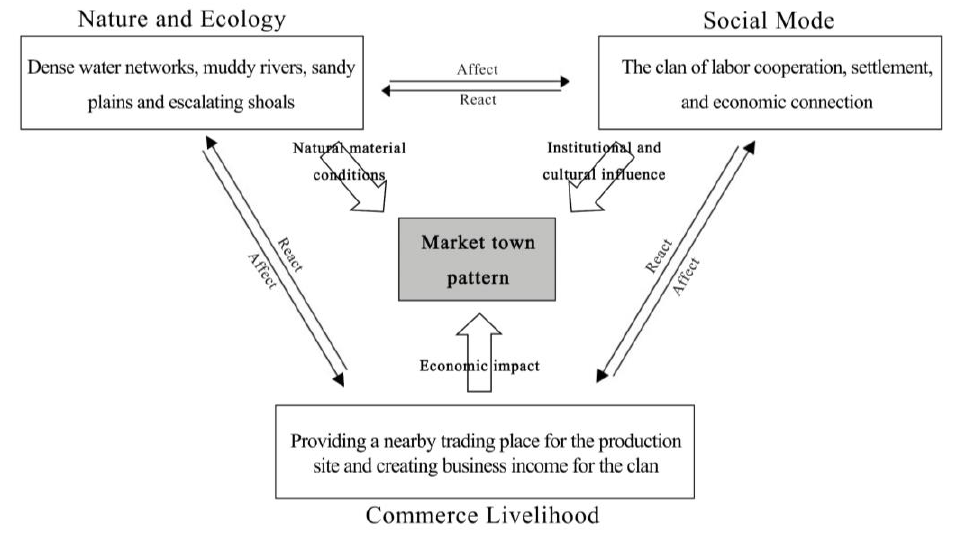
Figure 10. The relationships among ecological environment, social organization, and business livelihood patterns and their correlation with market town patterns.